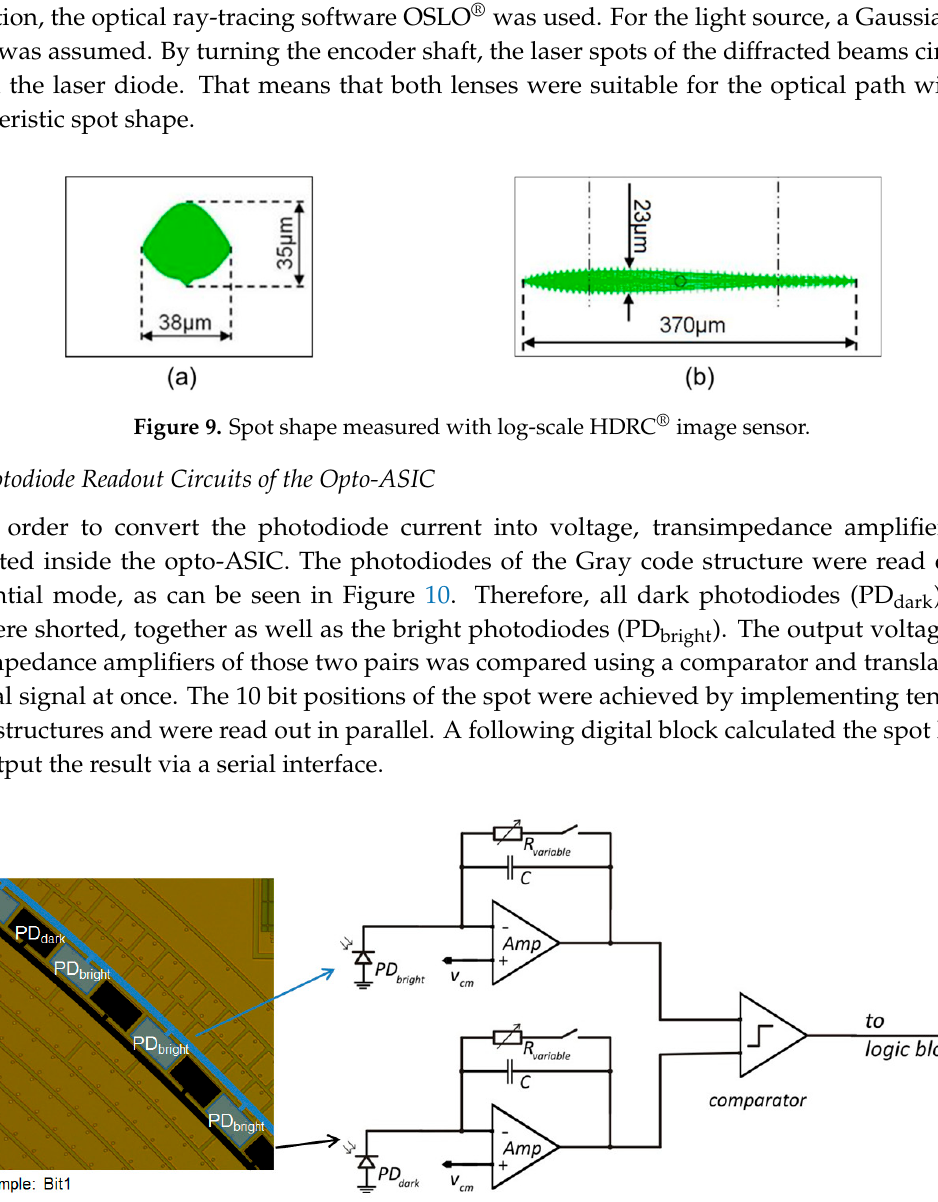
Figure 8. Spot shape measured with log-scale HDRC ® image sensor.